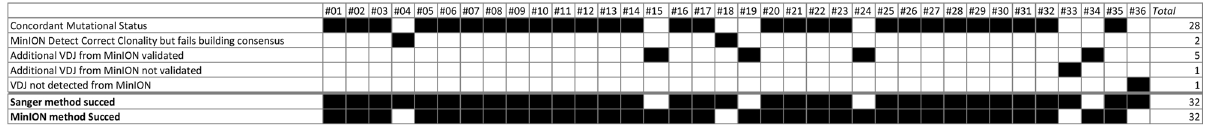
Figure 2. Summary of results considering as primary goal the determination of the correct mutational status. The success of the analysis is indicated with the black box. Besides the concordant status category, other categories represent differences both in clonality assessment and consensus building.